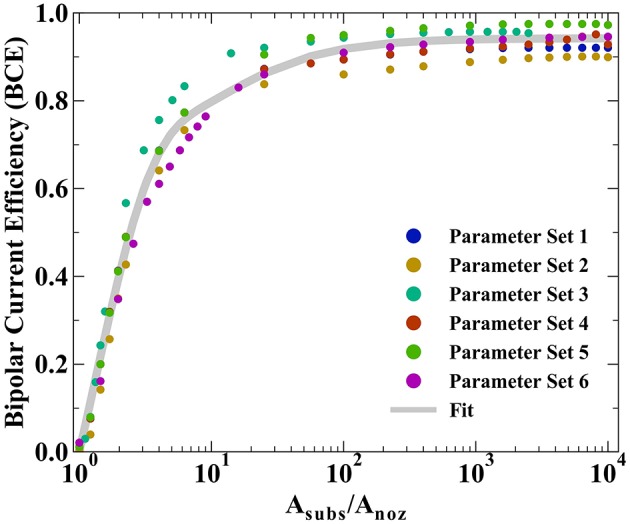
Bipolar current efficiencies (BCE) plotted vs. the ratio of total substrate area (Asubs) to nozzle area (Anoz) defined by ri. The varied parameters are highlighted in Table 1 and the fit is modeled by Equation 10.